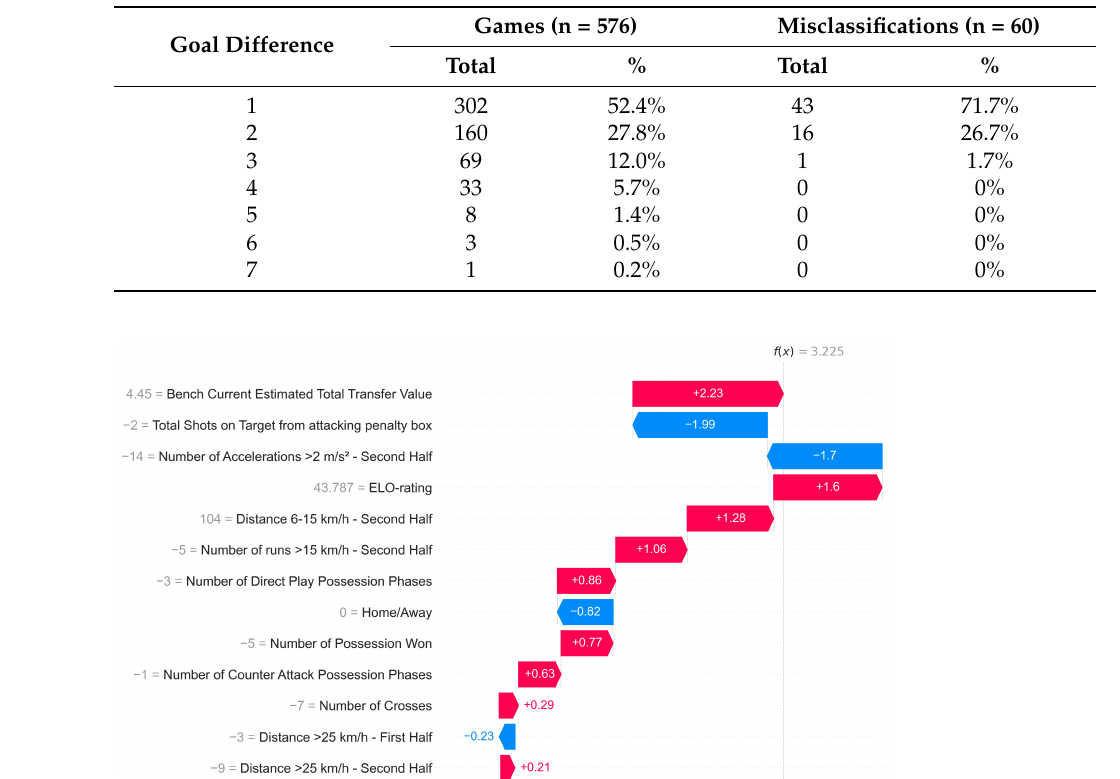
Table 2. An overview on the total and relative number of games and misclassifications for each goal difference.